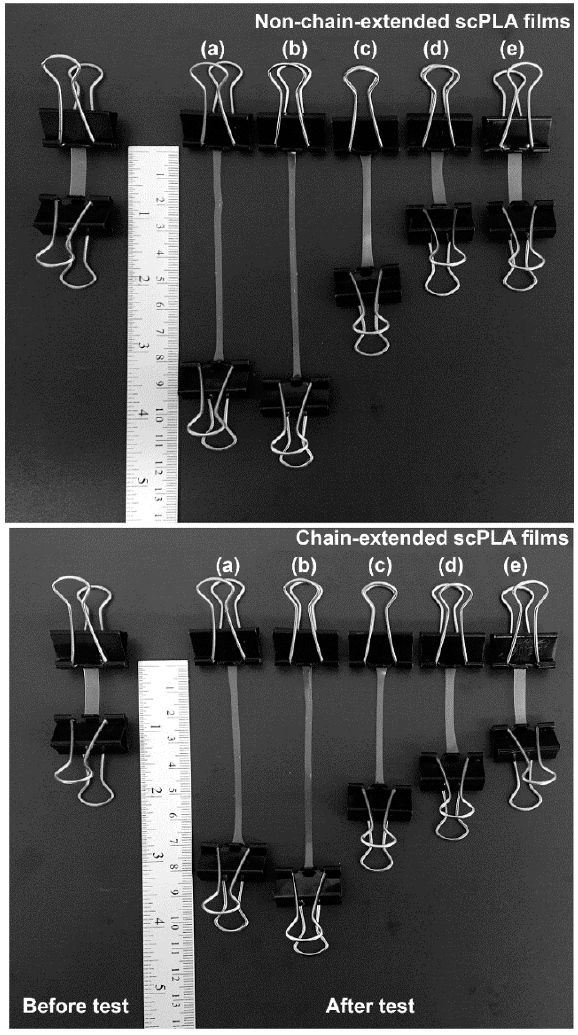
Figure 5. Dimensional stability to heat of (above) non-chain-extended and (below) chain-extended scPLA films with PLLA/PDLA ratios of (a) 100/0, (b) 90/10, (c) 80/20, (d) 70/30 and (e) 60/40 ( w / w ).